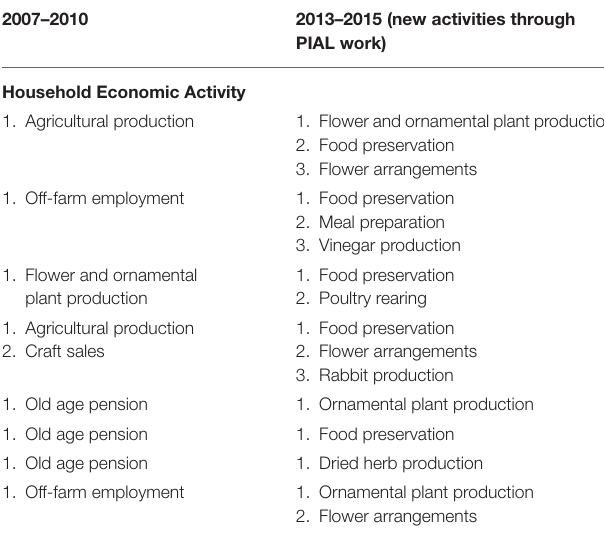
TABLE 1 | Diversification of household economic activity as a result of PIAL in eight households, San José de las Lajas Municipality, Mayabeque Province. 2007–2010 2013–2015 (new activities through PIAL